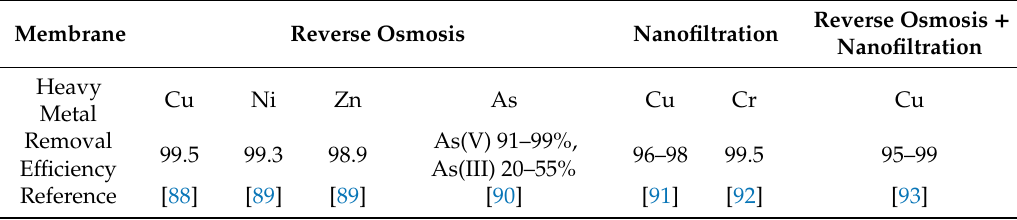
Table 5. A list of selected examples of heavy metal removal e ffi ciencies by RO, NF and NF +